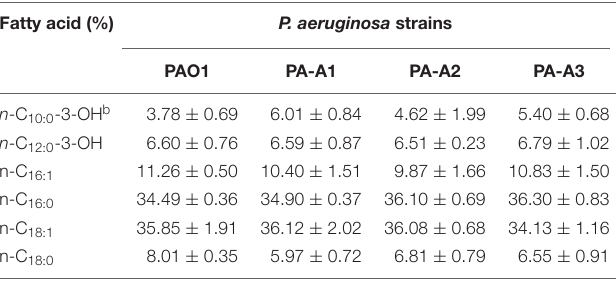
TABLE 1 | Fatty acid composition of total lipid extracts from Pseudomonas aeruginosa strains a .